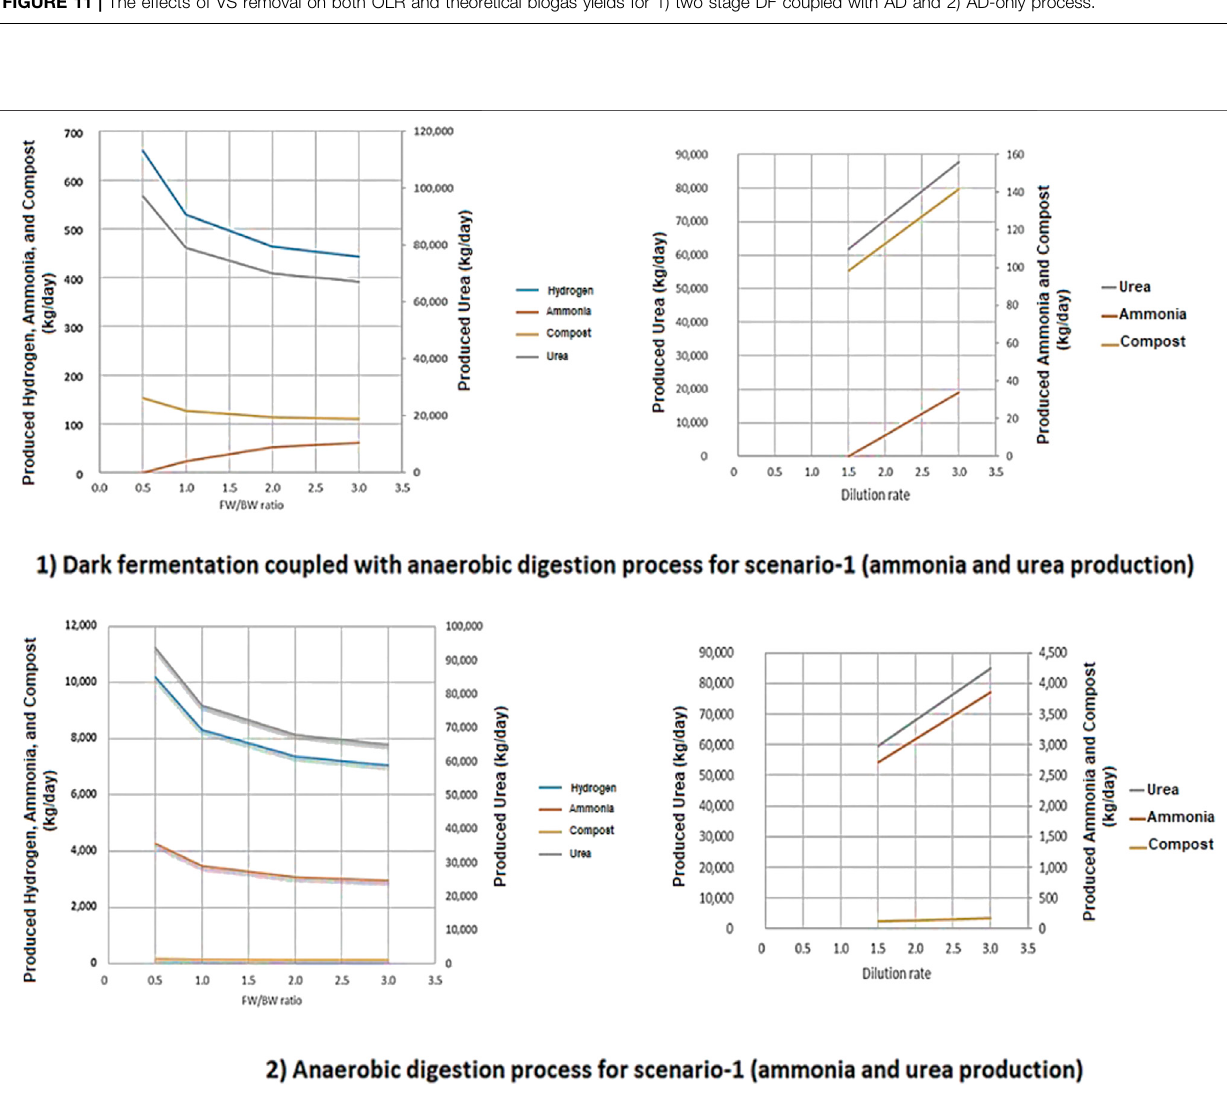
Frontiers in Energy Research |